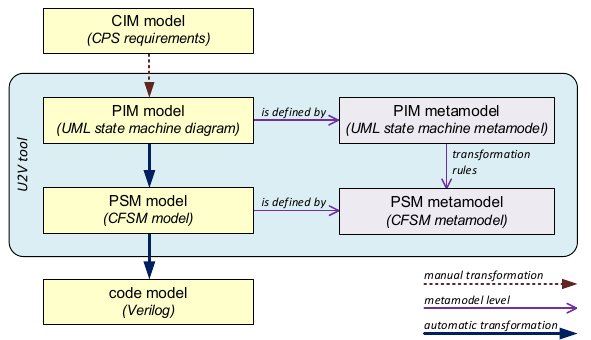
Figure 4. The model transformation path from the CIM model to the code model.